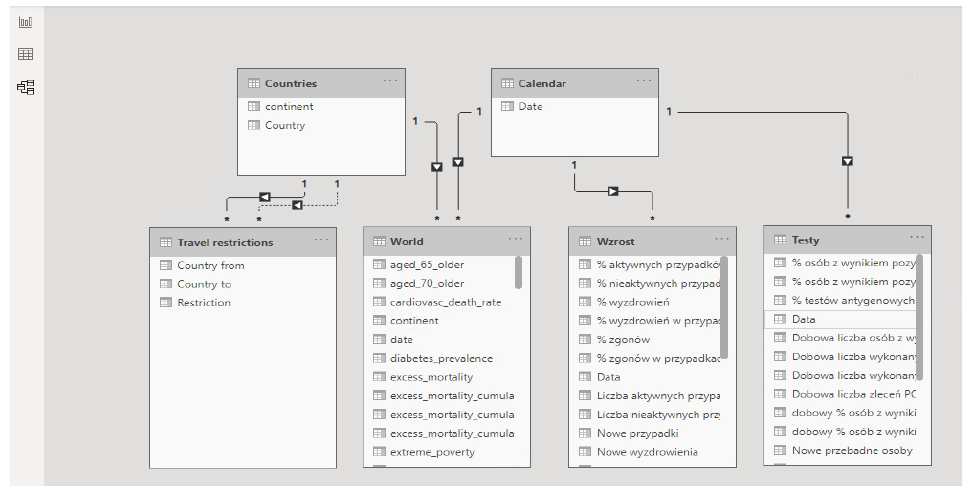
Figure 4. Part of the transformed table from the Power BI view . Source: Authors own elaboration.